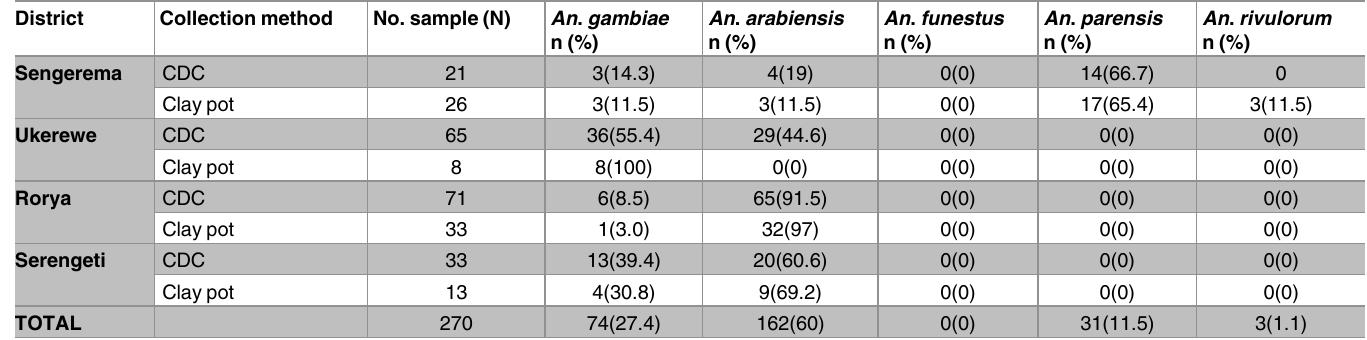
Table 3. Anopheline mosquito species identification collected by CDC light traps and clay pots method from sentinel sites in Lake Victoria, basin.